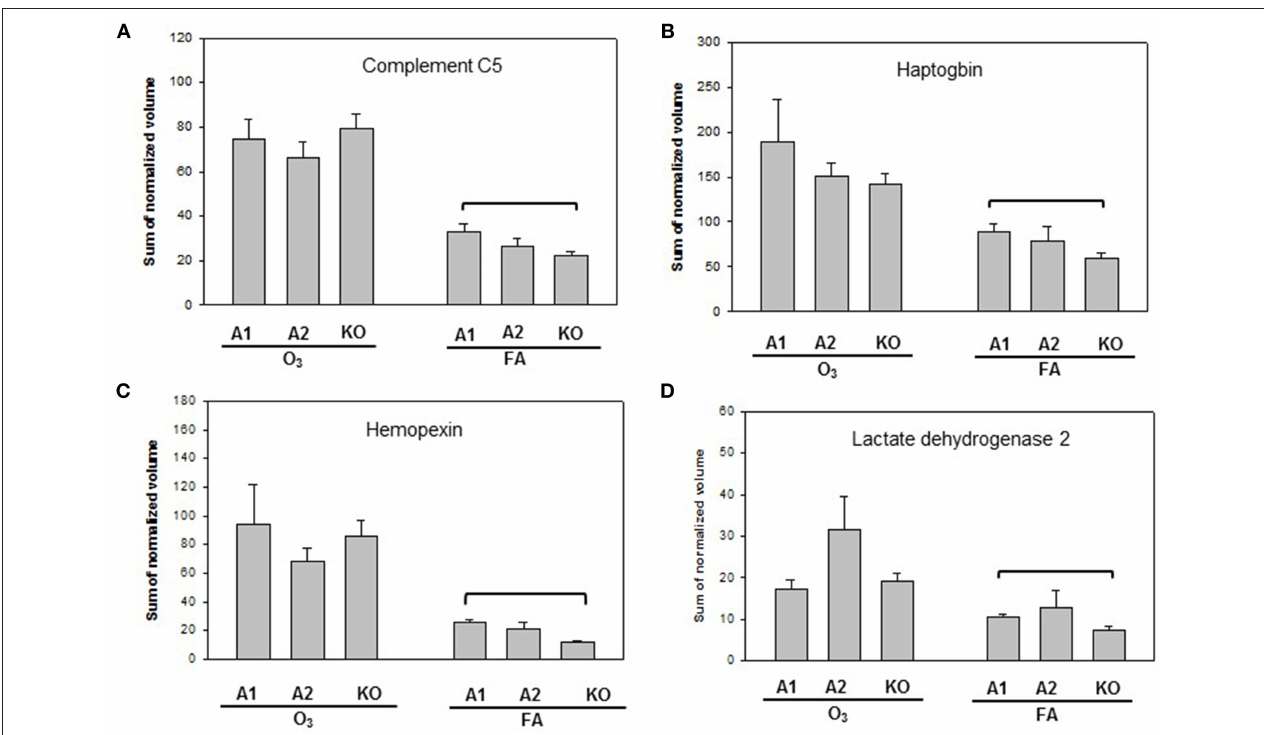
FIGURE 6 | Representative graphs of specific protein changes among genotypes of FA-exposed mice. Histograms depicting levels of each specific protein are included in (A) complement C5; (B) haptoglobin; (C) hemopexin; and (D) Lactate dehydrogenase 2. These proteins exhibit significant differences in one of the comparisons of male mice with different genotypes (A1, A2, KO) after exposure to filtered air (FA) and bacterial infection. Comparisons between groups that were statistically significant ( p < 0.05) are indicated with a